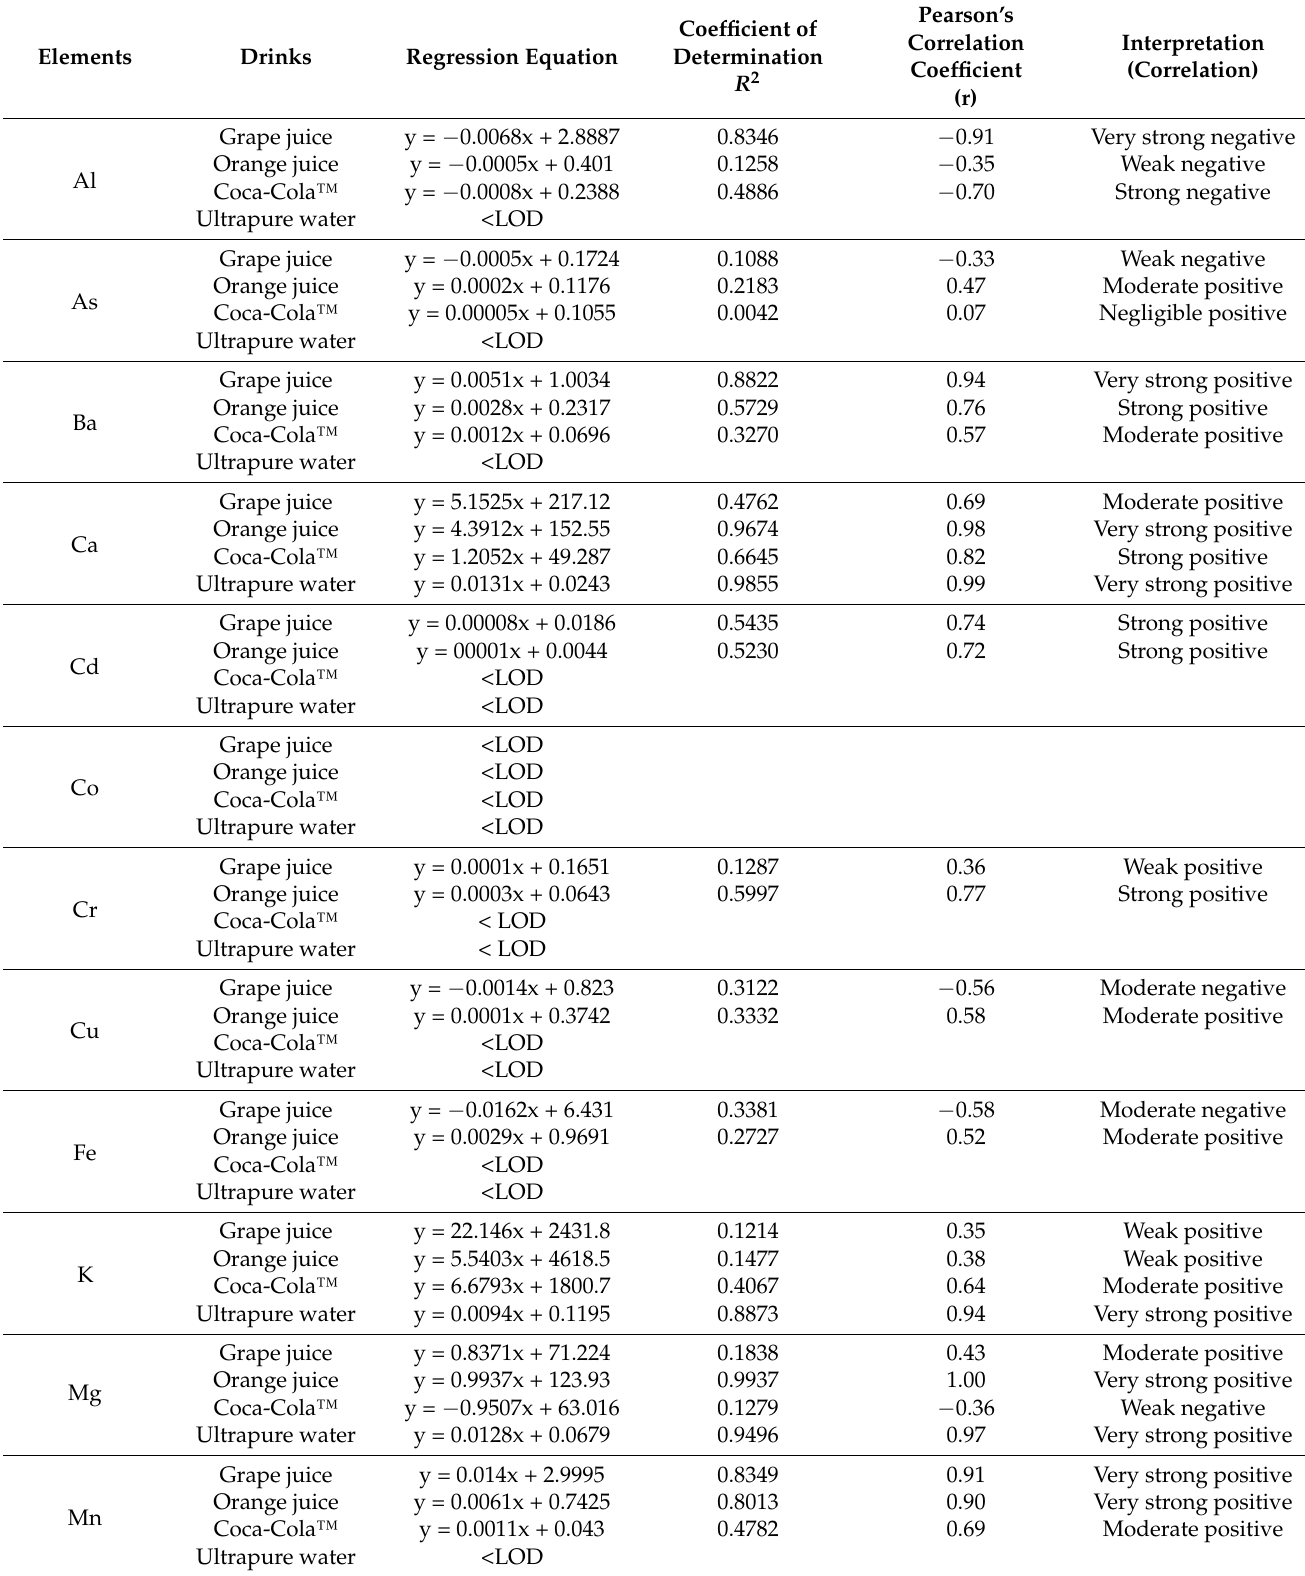
Table 4. Regression equation, coefficient of determination and Pearson’s correlation coefficient obtained from the concentra- tion of minerals detected before and after the erosive